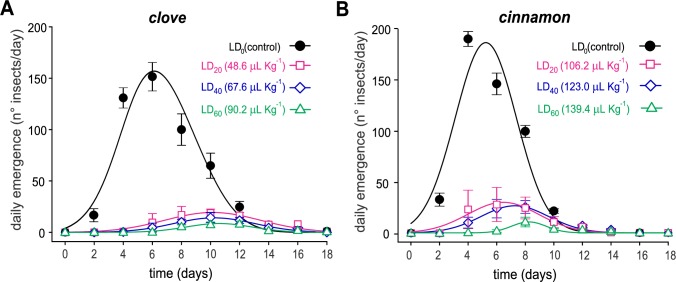
Average emergence of C. maculatus exposed to clove (A) and cinnamon (B) essential oils. The symbols represent the means of four replicates of the LD0 (control), LD20, LD40, and LD60 for each oil. The doses are expressed in μL of essential oil/kg beans. The vertical bars represent the SD.